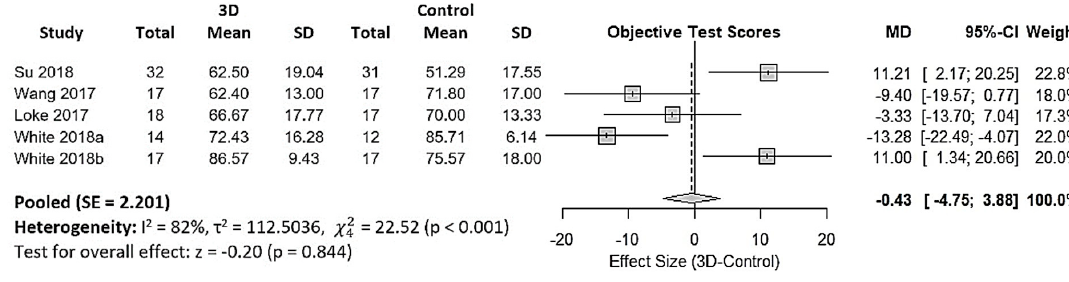
Figure 4. Forest plot for mean differences in test scores between the 3DPHM and the control groups. 3D, three-dimensional; CI, confidence interval; MD, mean difference; SD, standard deviation; SE, standard error.